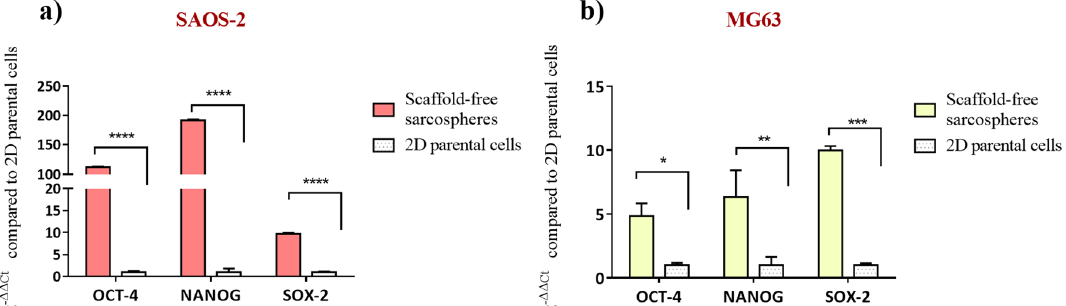
Figure 2. Gene expression analysis of scaffold-free sarcospheres. Relative quantification of scaffold-free sarcospheres gene expression of OCT-4, NANOG and SOX-2 in ( a ) SAOS-2 and ( b ) MG63 cell lines by qPCR. The graphs show the fold change expression of the genes relative to 2D parental cells (mean ± standard error; **** p value ≤ 0.0001; *** p value ≤ 0.001; ** p value ≤ 0.01; * p value ≤ 0.05).